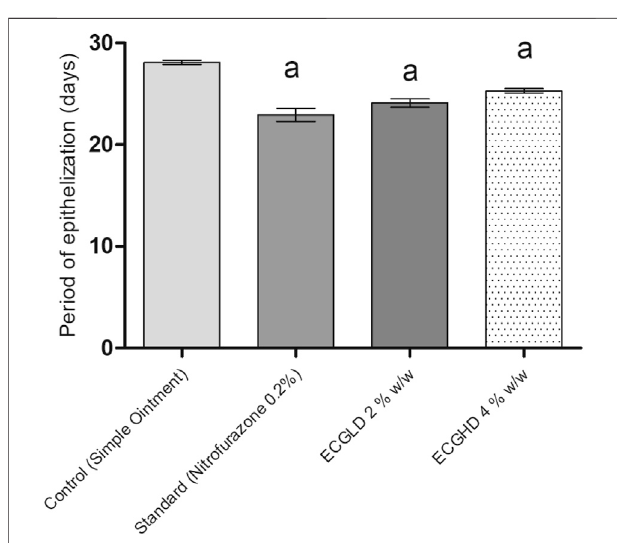
FIGURE 5 | ECPLD: extract of C. gigantea (L.) Dryand low dose; ECPHD:extractof C.gigantea (L.)Dryandhighdose;a (cid:2) P ≤ 0.001 vs.control; b (cid:2) p ≤ 0.01 vs. control; c (cid:2) p ≤ 0.05 vs. control.